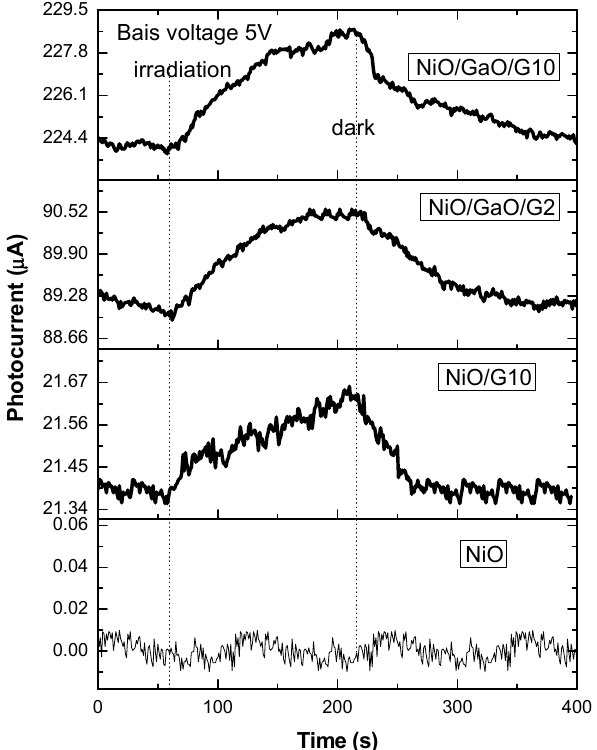
Figure 11. The photocurrent signal as a function of time for NiO, NiO/G10, NiO/Ga 2 O 2 /G2, and NiO/Ga 2 O 2 /G10 nanocomposites.